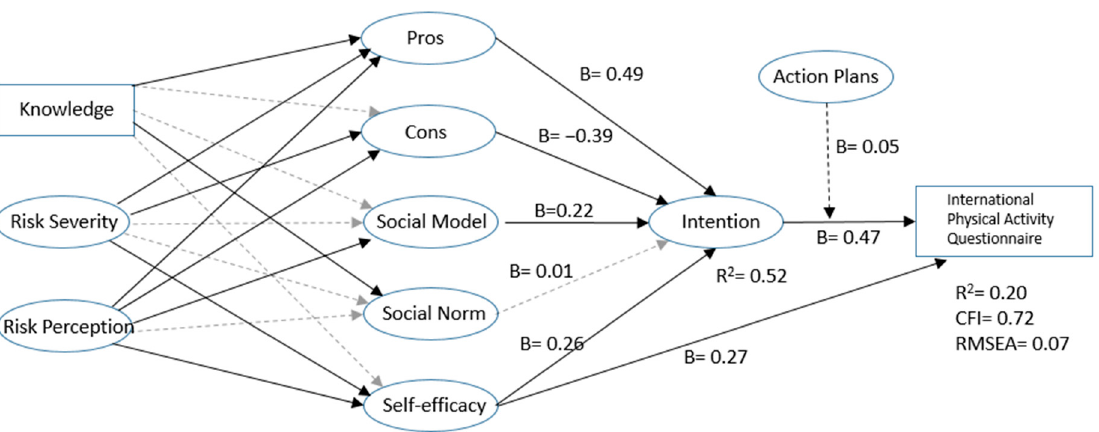
Figure 2. Unstandardized regression coefficients for ICM.